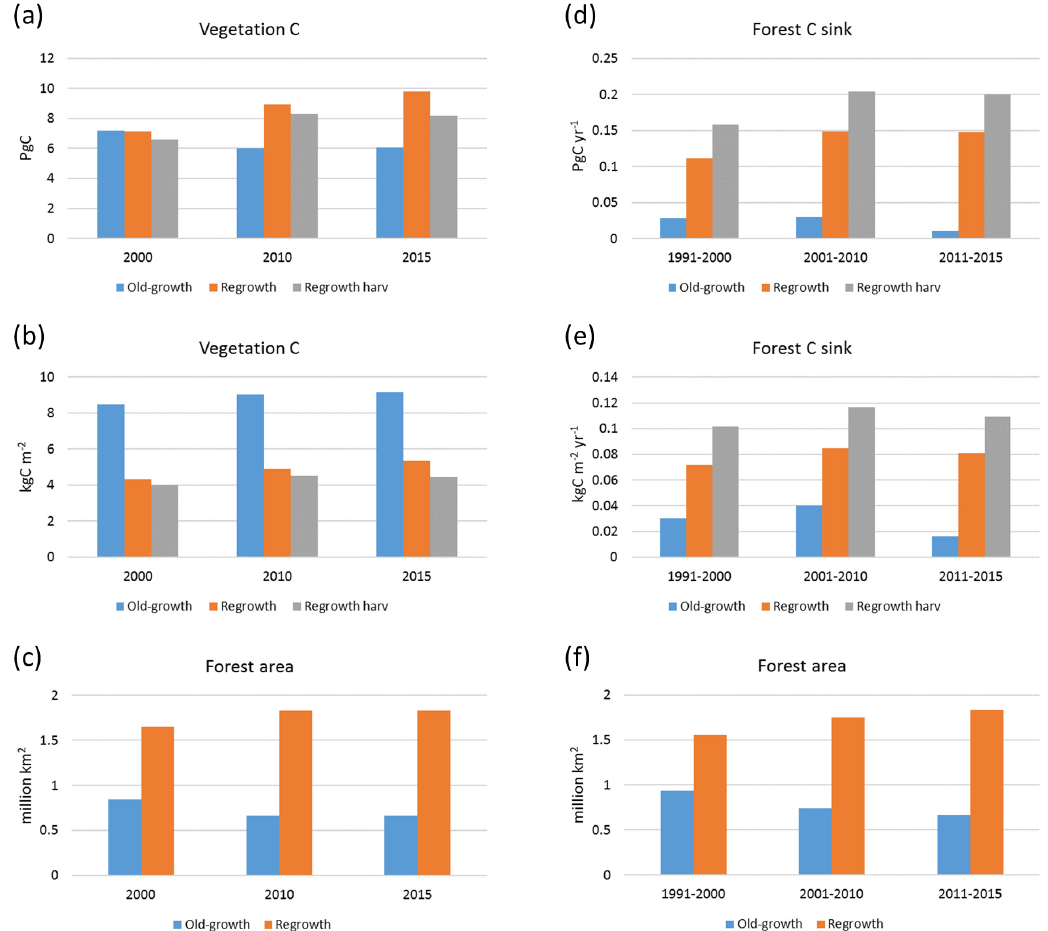
Figure 12. Modelled European forest vegetation carbon for 2000, 2010, and 2015 and carbon sink ( = − NEE) for the periods 1991–2000, 2001–2010, and 2011–2015, separated into old-growth and regrowth forests (with and without wood harvest in regrowth forest): (a) vegeta- tion carbon; (b) vegetation carbon per area; (c) old-growth and regrowth forest area in 2000, 2010, and 2015; (d) total forest carbon sink; (e) mean forest carbon sink per area; (f) old-growth and regrowth forest area in 1991–2000, 2001–2010, and